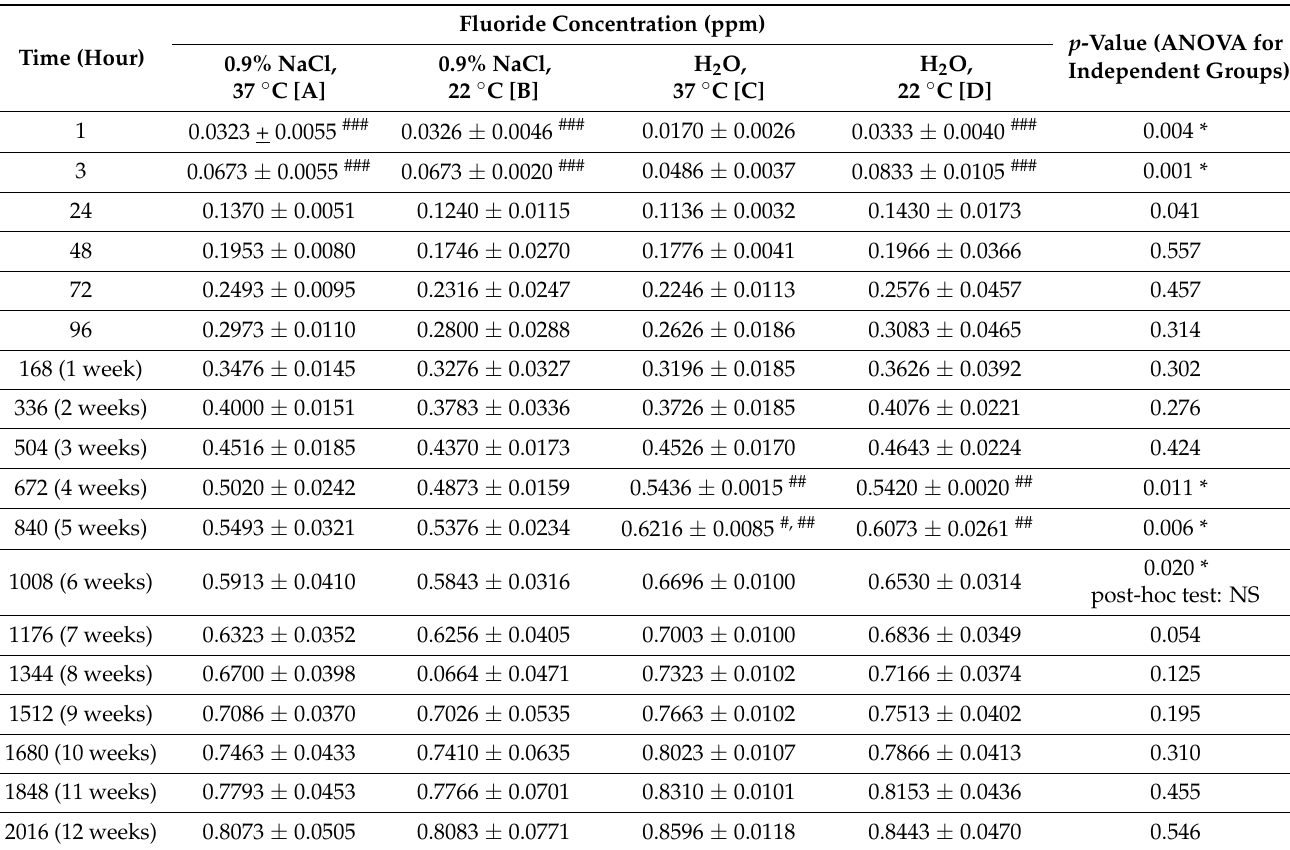
Figure 4. Relationship between time points and release of fluoride ions into a saline solution or deionized water. Dots represent the means of measurements. Table 2. Cumulated in vitro release of fluoride ions from nanofluorapatite into a saline solution or deionized water. Descriptive data were presented as the mean ± standard deviation ( ±